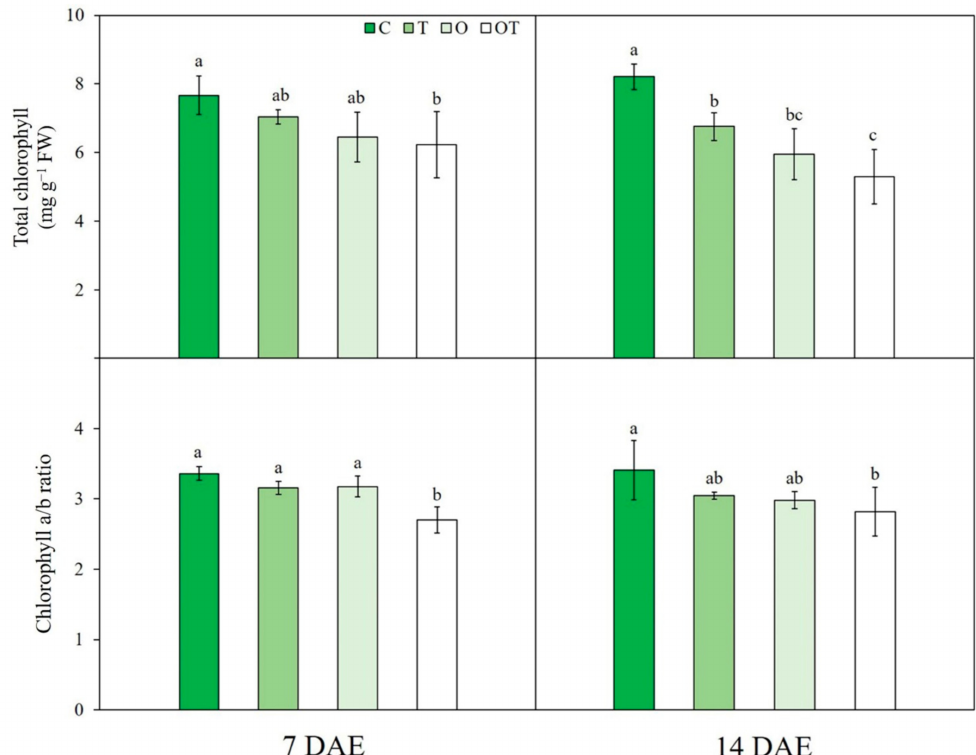
Figure 4. Total chlorophyll content and chlorophyll a/b ratio of Brassica juncea L. under different ambient and supraoptimal temperatures and O 3 concentrations at 7 and 14 DAE. Data are plotted as mean ± SD ( n = 5). Different letters indicate significant differences among treatments at p < 0.05 according to Tukey’s honestly significant difference test. C: ambient O 3 + optimal temperature; T: ambient O 3 + supraoptimal temperature; O: elevated O 3 + optimal temperature; OT: elevated O 3 + supraoptimal temperature; DAE: days after the beginning of